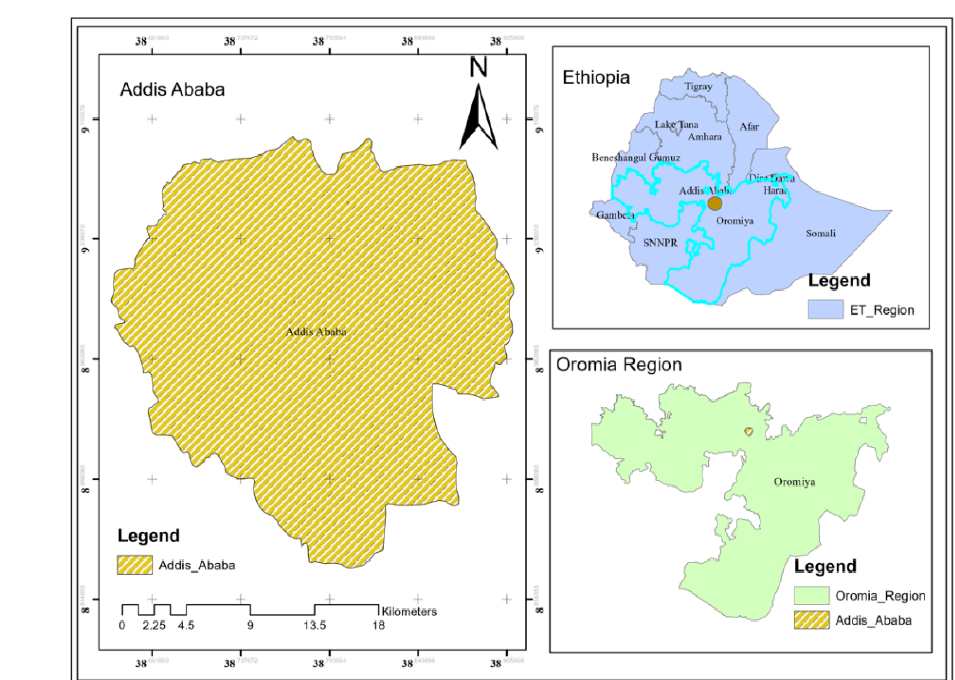
Figure 1. Location of Addis Ababa in Ethiopia Source: Developed using ArcGIS.